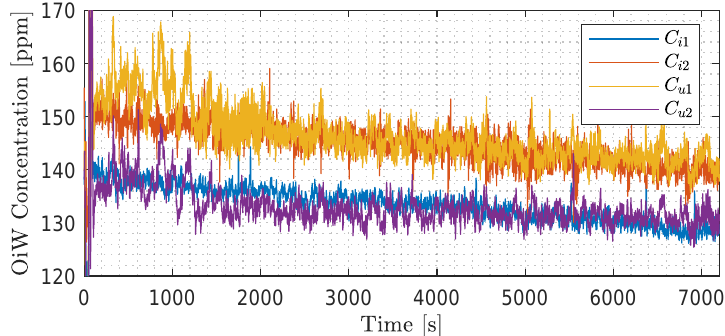
Figure 19. All four OiW monitors configured to be on a single